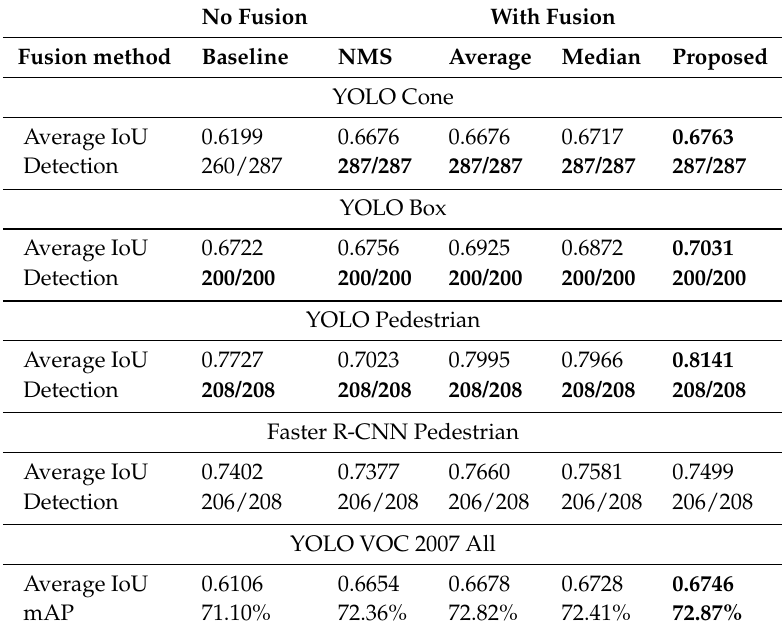
Table 2. ADAS experimental results. Baseline means there is no fusion performed, that is only the original image is